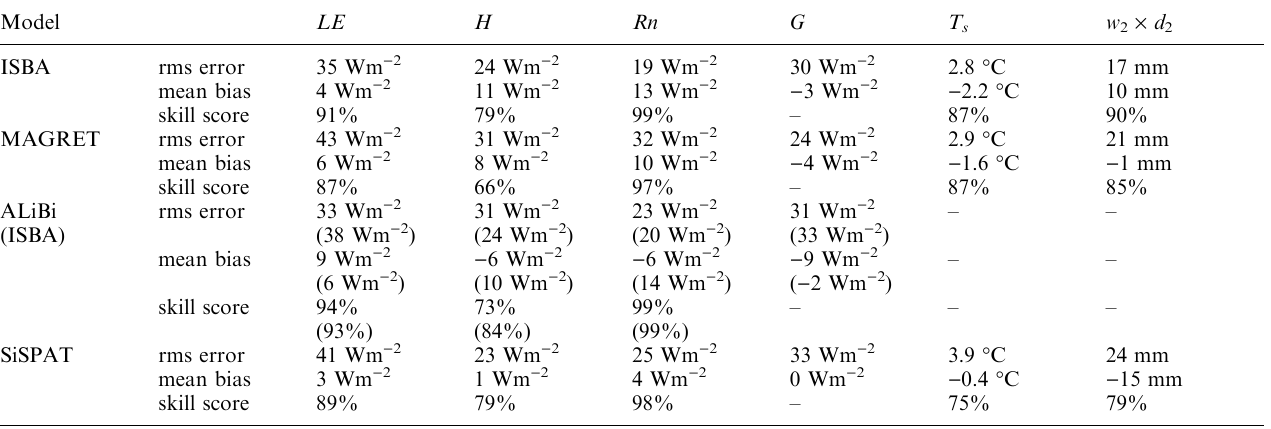
Table 4. Errors a(cid:128)ecting the simulated half-hourly outputs of ISBA, MAGRET, ALiBi, and SiSPAT in terms of rms error, mean bias (simulated minus observed), and model skill score on: evapotranspiration ( LE ), heat flux ( H ), net radiation ( Rn ), soil